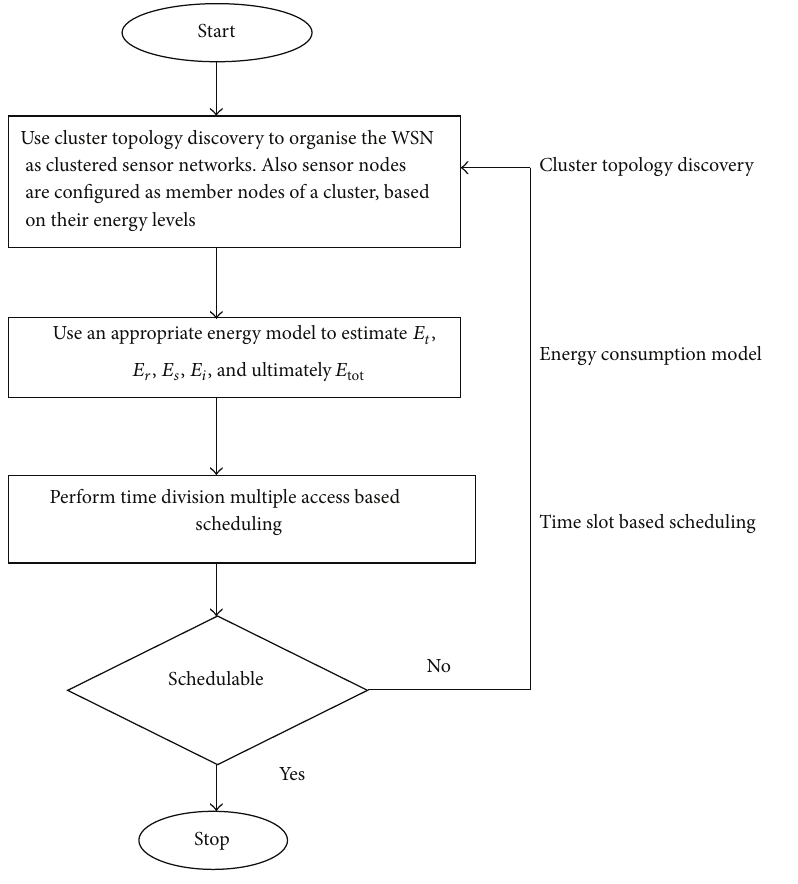
Figure 2: Flowchart of proposed scheme. Table 2: Simulation